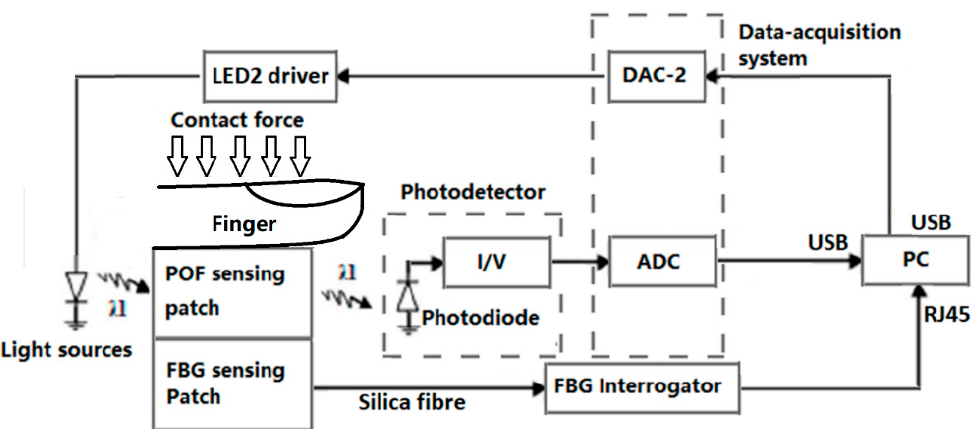
Figure 1. ( a ) Schematic diagram of a plane view of the probe. The red frame represents the POF connected to an infrared LED (centre wavelength λ = 850 nm). The yellow frame represents the POF connected to a photodiode. As the sensor has been adapted from a pulse oximeter described previously, there is an additional channel (orange frame) that exists which was not used in this investigation. The blue frame represents the stainless-steel tube. ( b ) Schematic diagram of a side view of the probe. The two sensors are encased in epoxy. The POFs transfer light from/to the skin, whilst the FBGs monitor the applied pressure. POF – polymer optical fibre and FBG – fibre Bragg grating, LED - Light emitting diode.